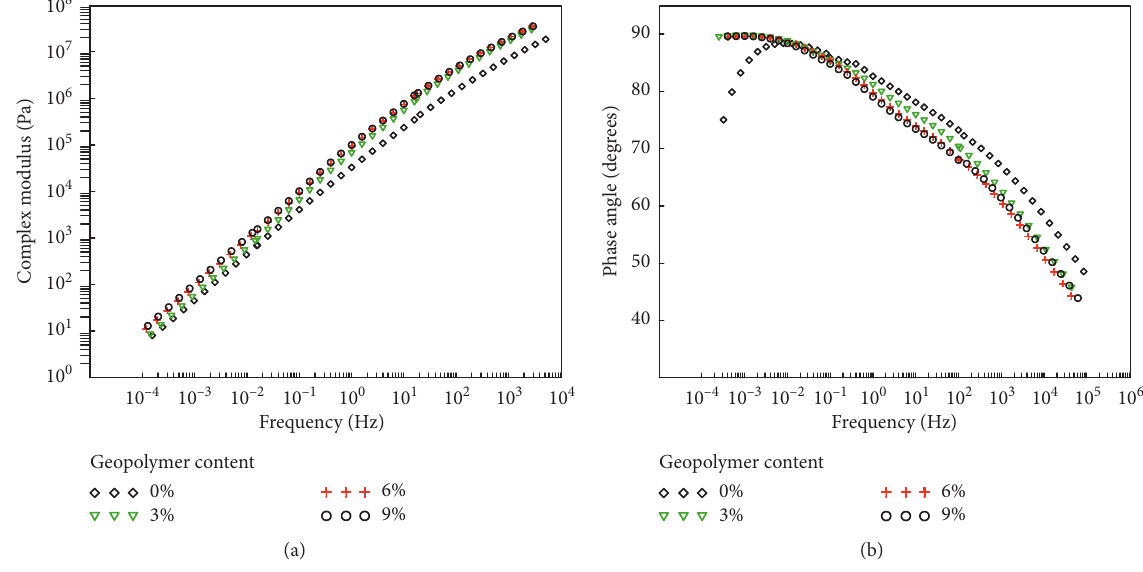
Figure 7: Rheological master curve at 35 ° C for (a) complex modulus and (b) phase